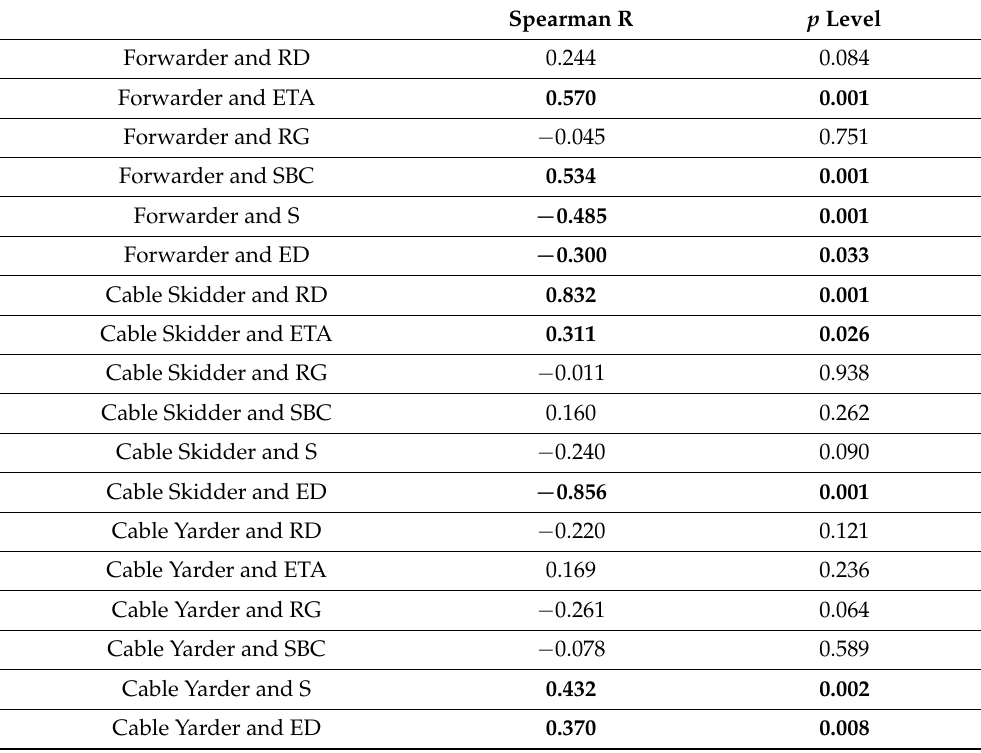
Table 6. Results of Spearman correlation analysis. In bold, statistically significant results ( p <